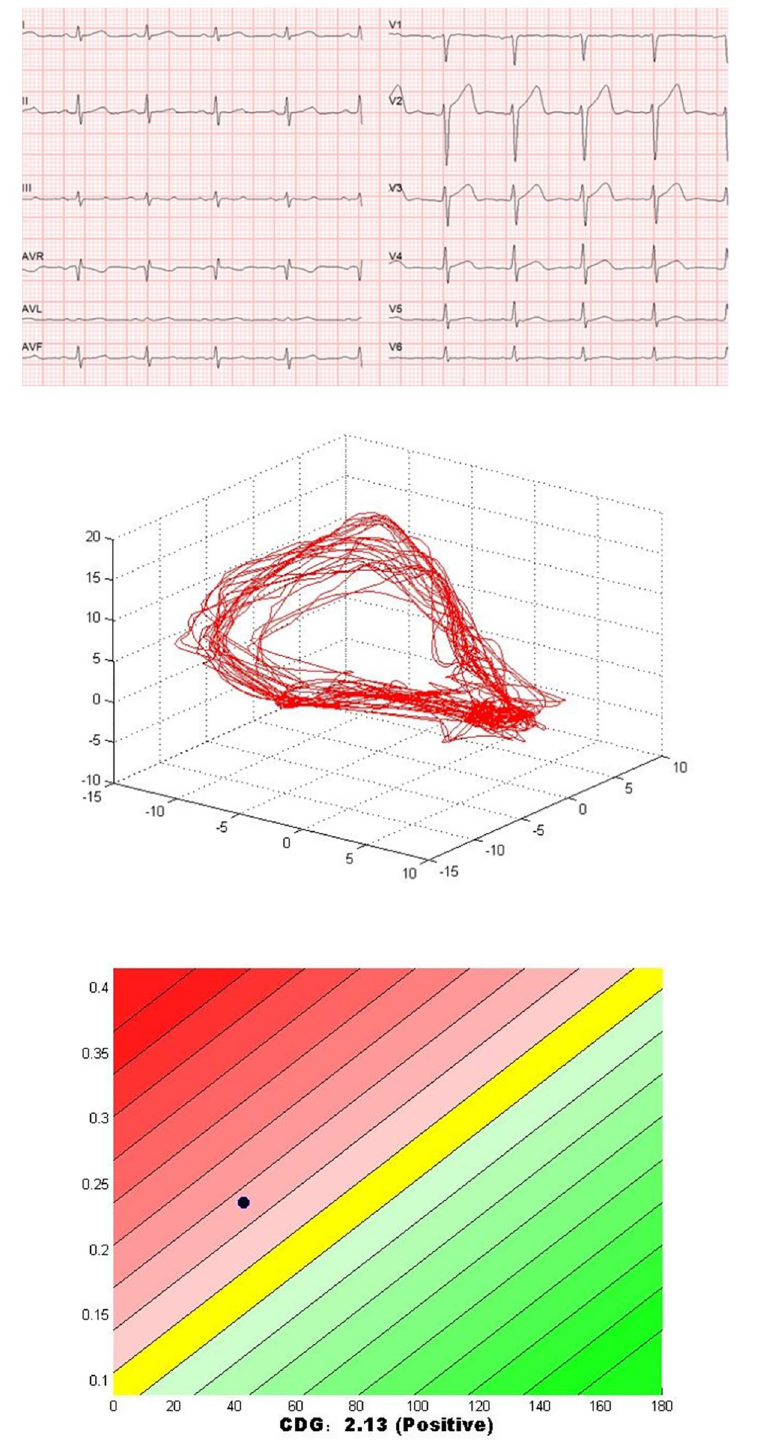
Fig 5. The ECG, CDG and DI of GB0880. GB0880 is a 42-year-old male patient with moderately severe stenosis, ECG is normal, and CDG is positive with DI = 2.13.